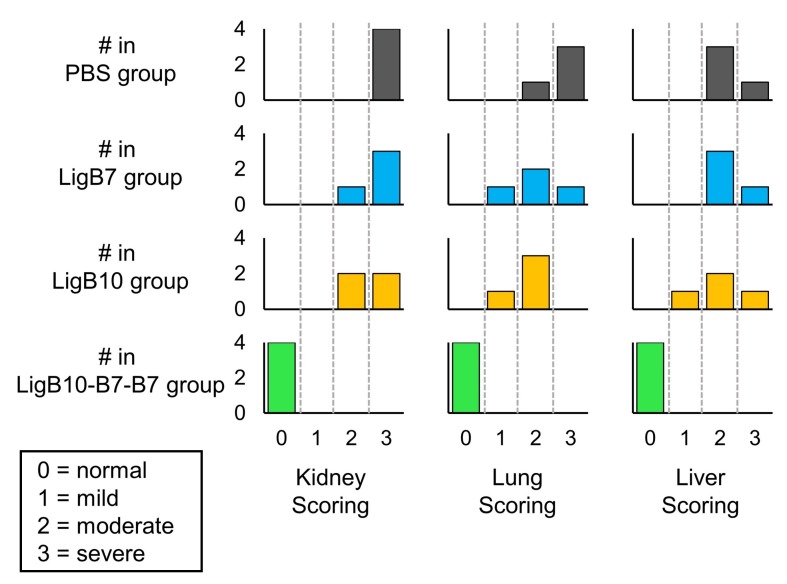
Histograms of post-challenged hamster tissue scores for PBS, LigB7, LigB10, and LigB10-7-7 inoculated groups.Respective tissues from four hamsters in each immunization group were individually harvested and fixed. Histopathological scoring was performed by a board certificated veterinary pathologist. Kidney tissues were graded for severity of renal lesions (0 = normal, 1 = mild, 2 = moderate, 3 = severe tubulointerstital nephritis). Lung tissues were graded for severity of hemorrhage (0 = normal, 1 = focal, 2 = multifocal, 3 = locally extensive areas of hemorrhage). Liver tissues were graded for the number of inflammatory foci (0 = normal, 1 = 1–3, 2 = 4–7, 3 =>7).